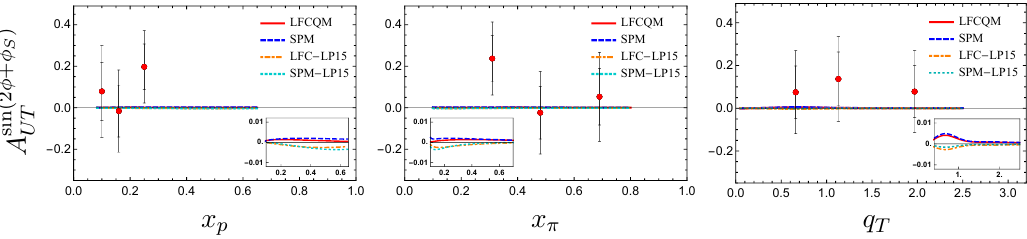
Figure 7 . A sin(2 (cid:30) + (cid:30) S ) as a function of x p (left), x (cid:25) (middle) and q T (right) vs COMPASS data [46]. UT